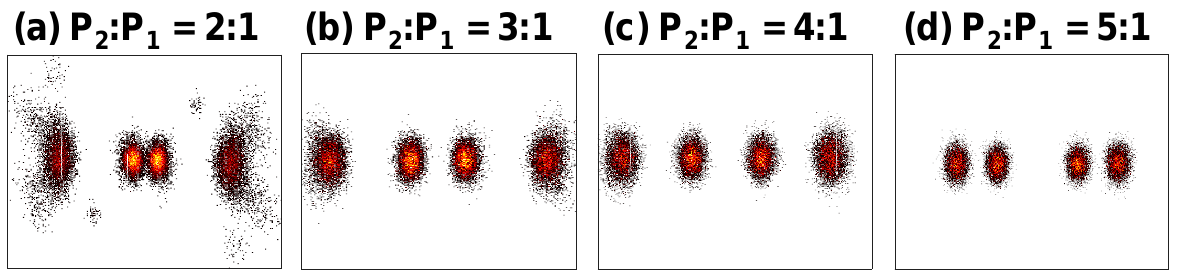
Figure 6. Experimental BER against different power ratios (Data 2: Data 1) of the OFDM-NOMA VLC systems using ( a ) BPSK and ( b ) QPSK.